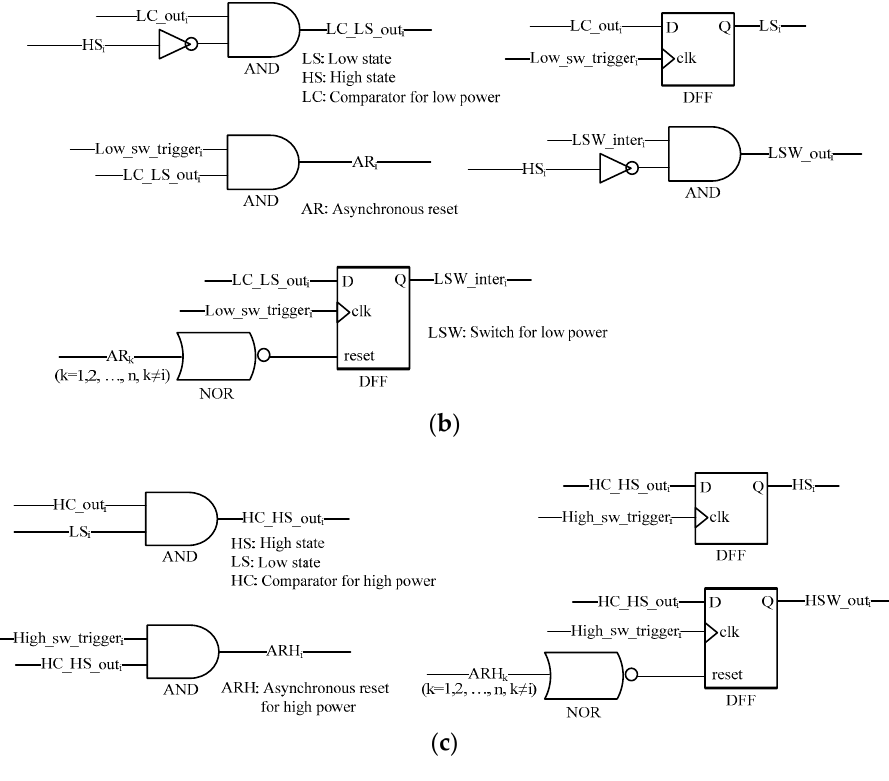
Figure 8. Block diagrams for the digital control logic. ( a ) trigger signal generator; ( b ) control signal generator for low power switch; ( c ) control signal generator for high power switch.